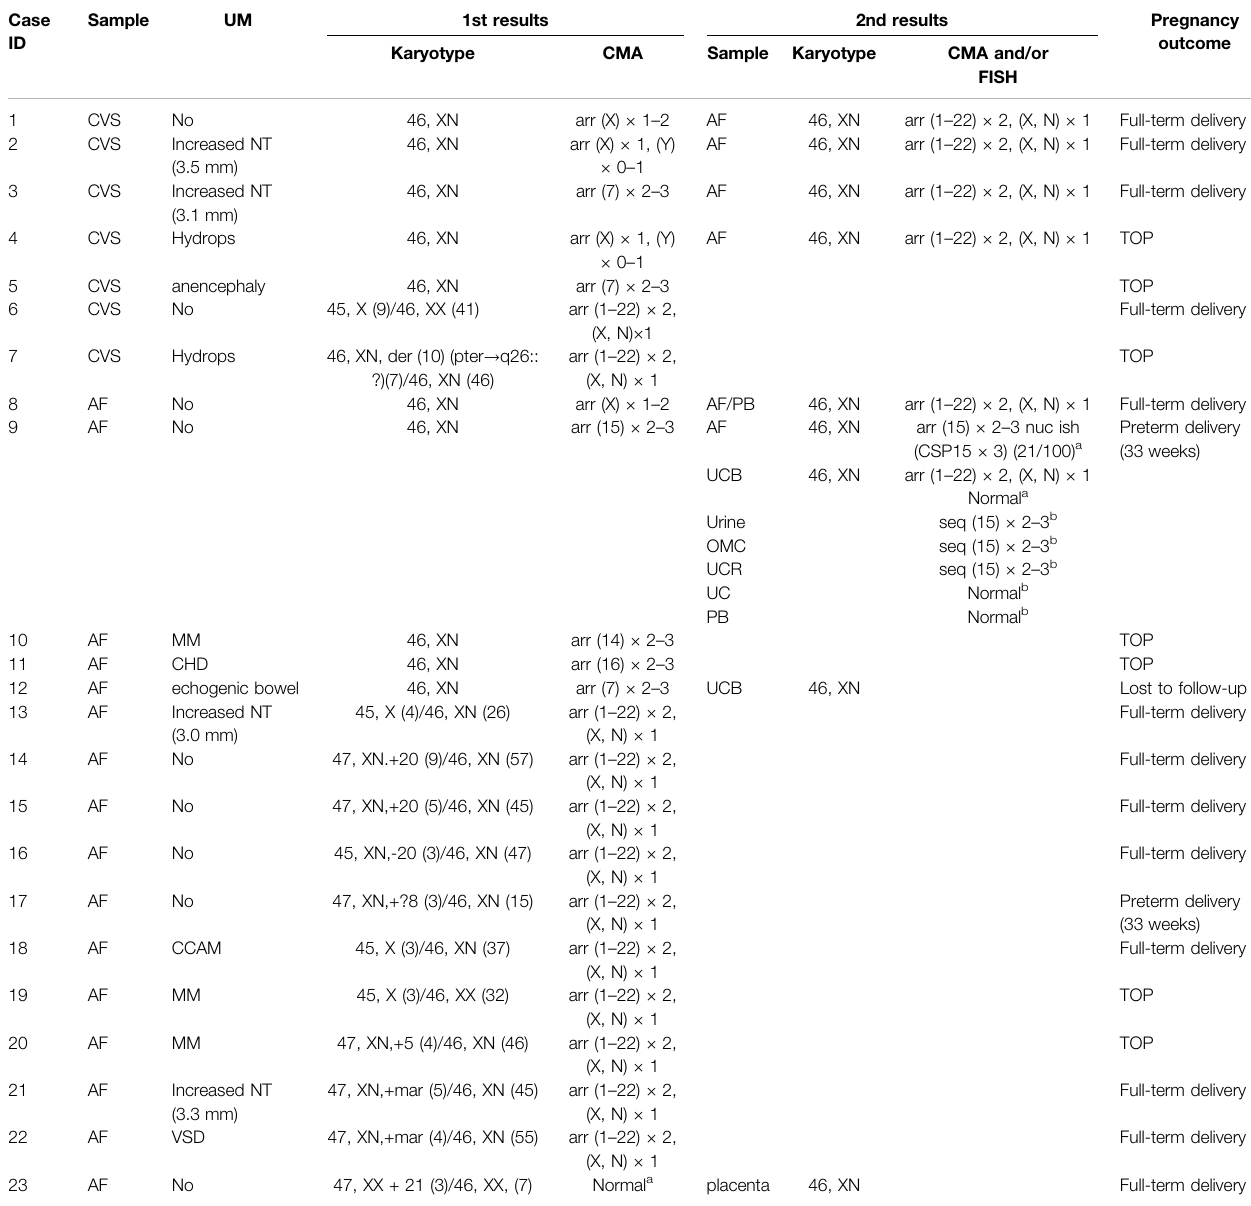
TABLE 3 | Inconsistent results in fetuses with CM between the karyotype and